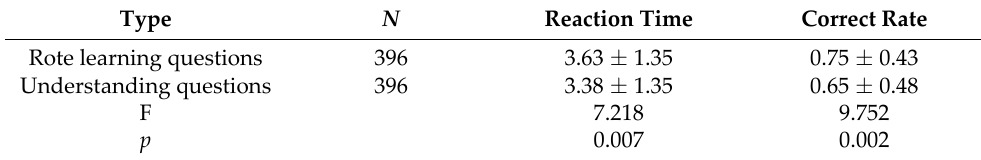
Table 6. Results of descriptive statistics of response time and correctness for question types.